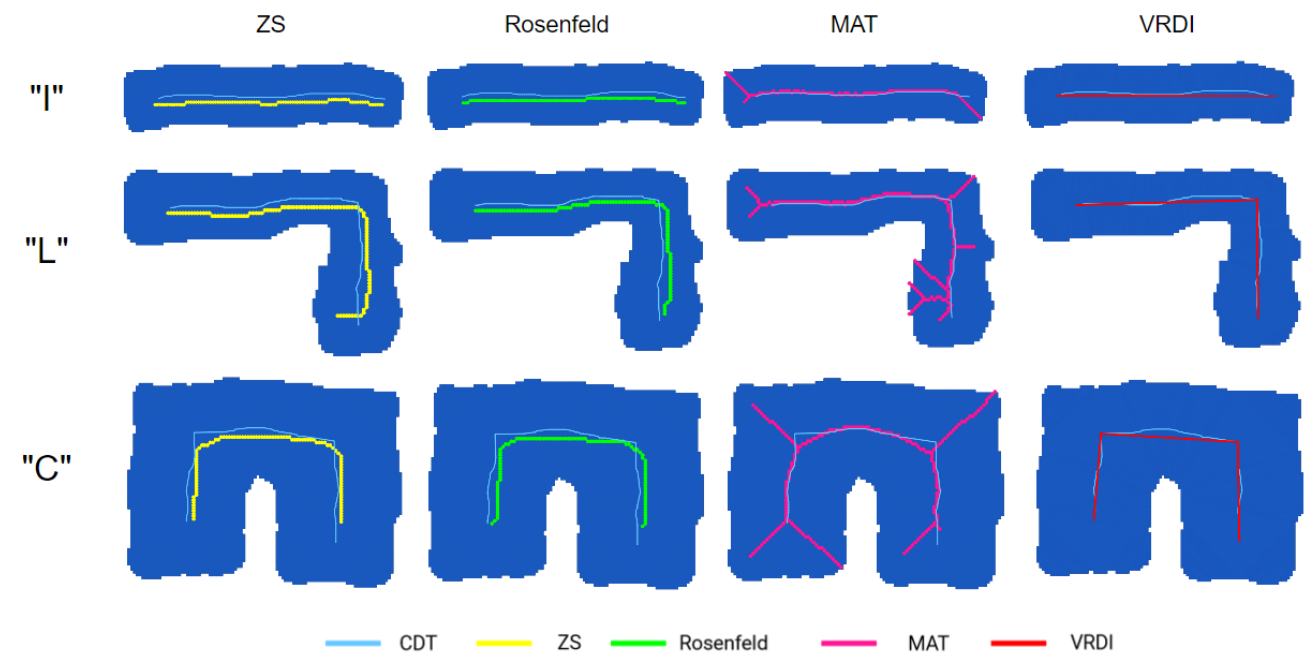
Figure 18. Building skeleton lines without crosspoints.